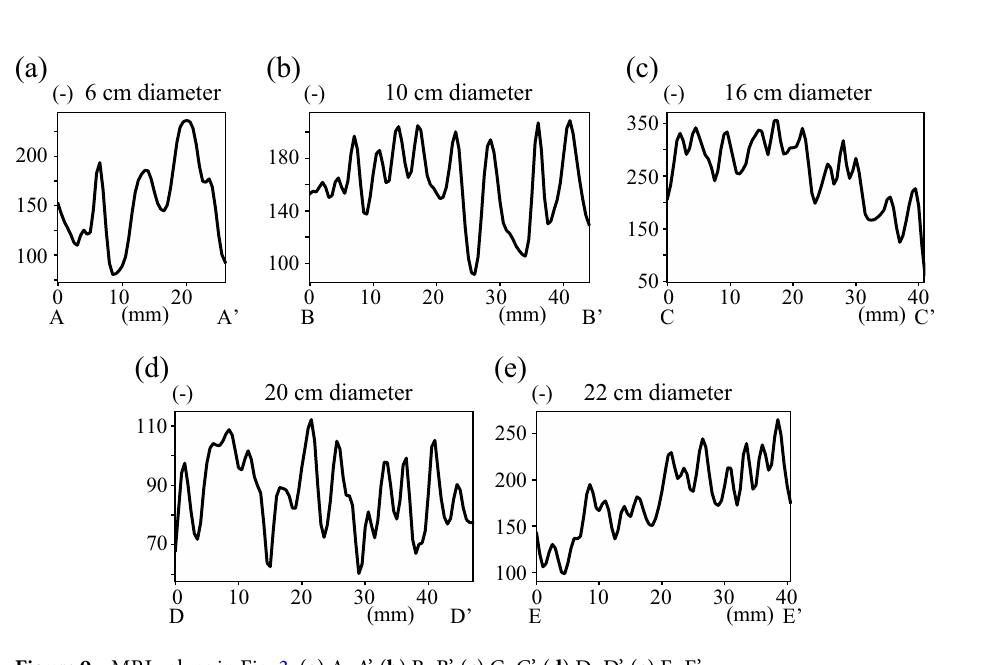
Figure 9. MRI values in Fig. 3. ( a ) A–A’, ( b ) B–B’, ( c ) C–C’, ( d ) D–D’, ( e )